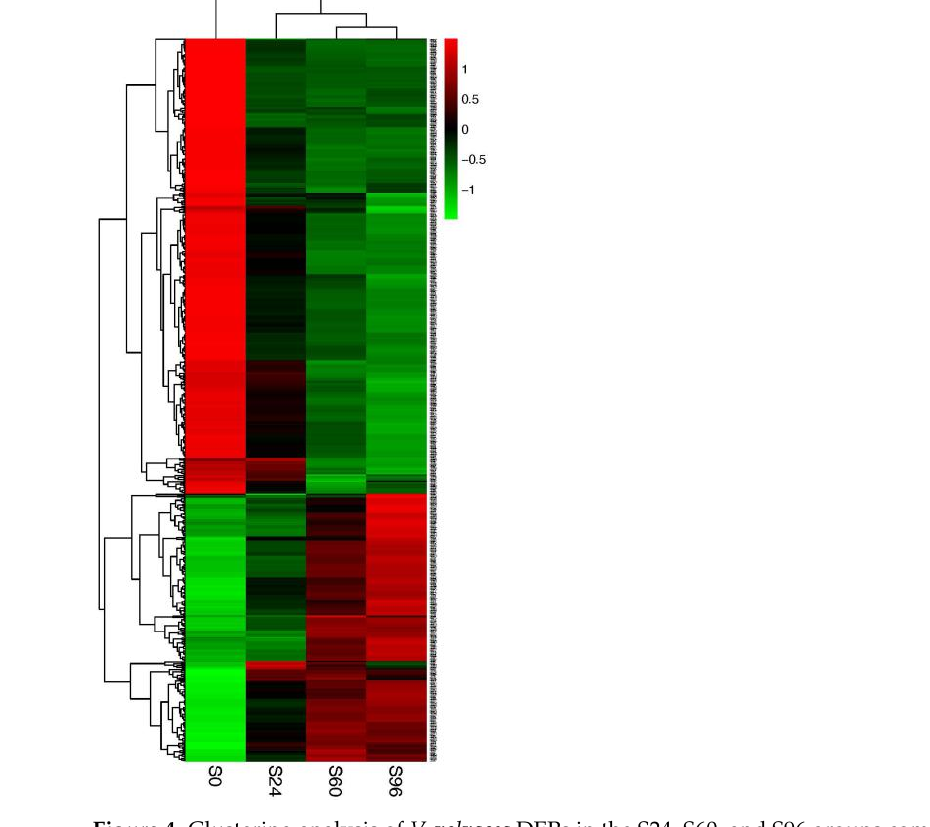
Figure 4. Clustering analysis of V. volvacea DEPs in the S24, S60, and S96 groups compared with the S0 group. Red, green, and black indicate an increase, decrease, and no change in protein abundance, respectively, compared with the baseline level.